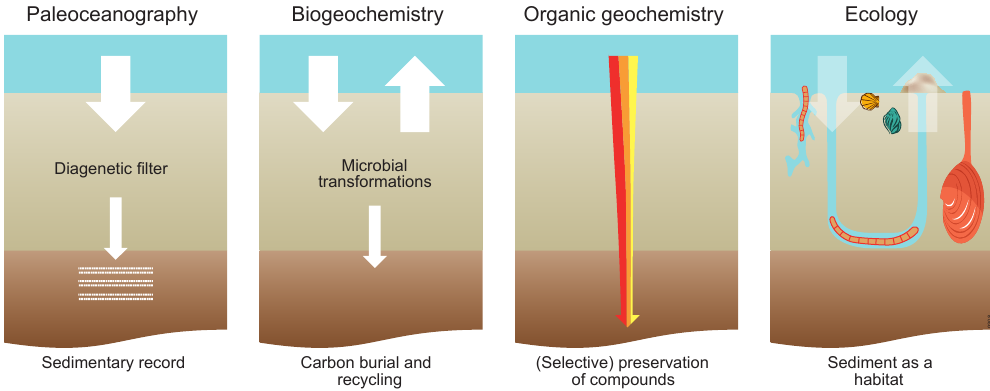
Figure 1. Different views on, approaches to and interests in carbon processing in marine sediments. Paleoceanographers focus on the sedi- mentary record, biogeochemists quantify carbon burial and recycling, organic geochemists study alteration of organic matter, and ecologists focus on carbon as food for organisms living in the sediment. The red–orange–yellow fractions of organic matter have a different